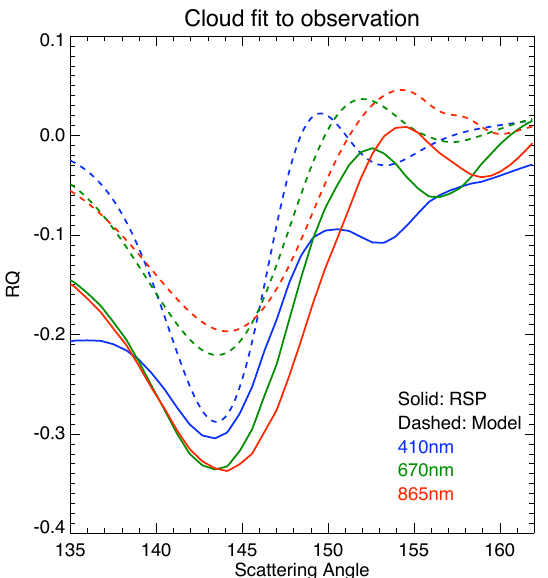
Fig. 7. RSP observations (solid lines) were matched to a look up table of cloud optical properties (dashed lines) to determine ini- tial cloud droplet size properties for the optimization. The cloud that matched best had droplets with an effective radius of ( r e , cl = 6 . 25µm) and effective variance of ( v e , cl = 0 . 075). Low frequency differences (bias) between cloud and RSP ( R Q ) are due to the ef- fects of aerosols and Rayleigh scattering on the observation.